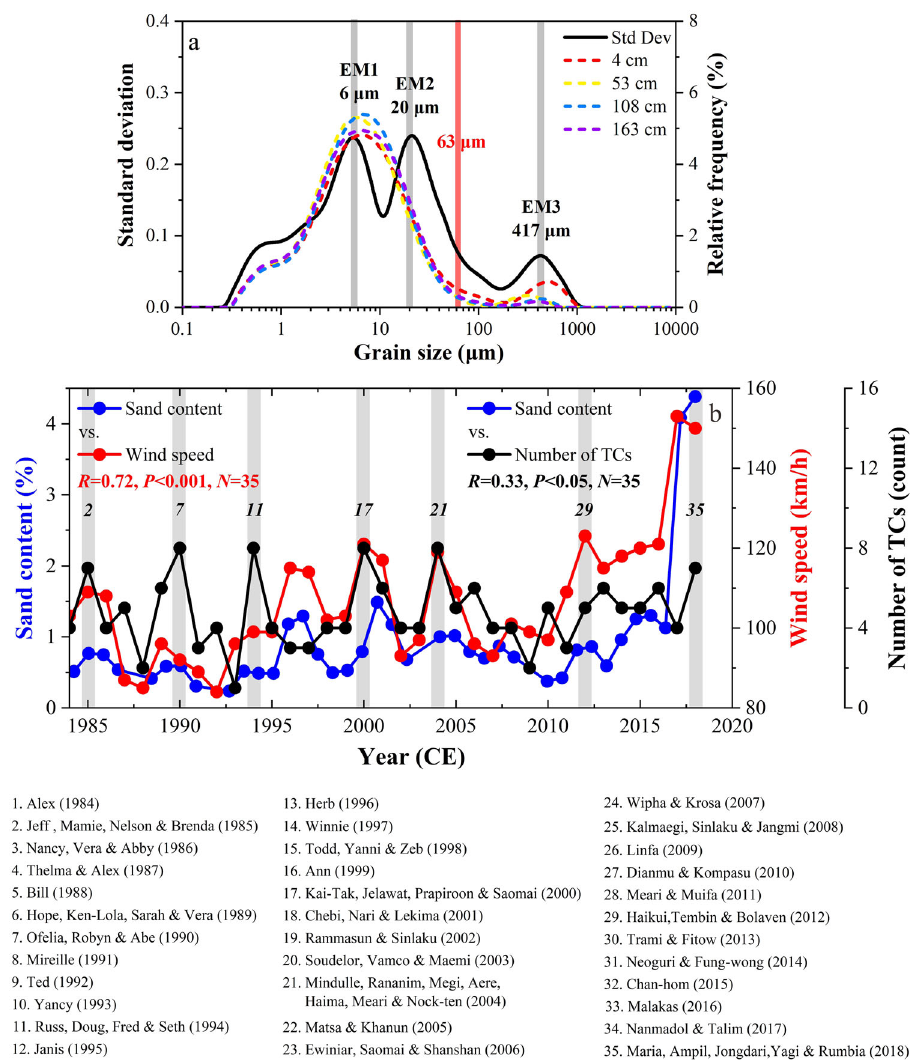
Fig. 2 Establishment of a TC activity proxy in the sediments of the ZFMB. a Results of grain-size analysis using grain size-standard deviation approach. Black line is a plot of standard deviation against grain size. Colored dotted lines show the grain-size distributions of selected samples. b Comparison of the sand content of core ZM01 with the number of TC events and the annual maximum wind speed of TCs passing through the region (1984 – 2018 CE). Selected TC events are numbered 1 –